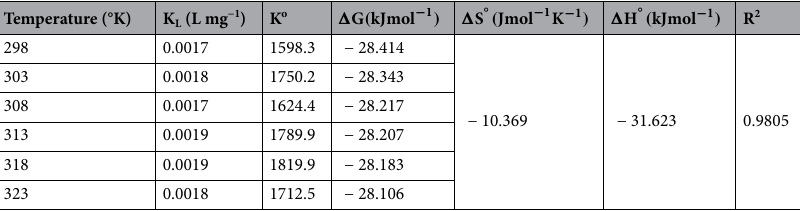
Table 10. Thermodynamic information of RR198 adsorption on MSW compost ash.